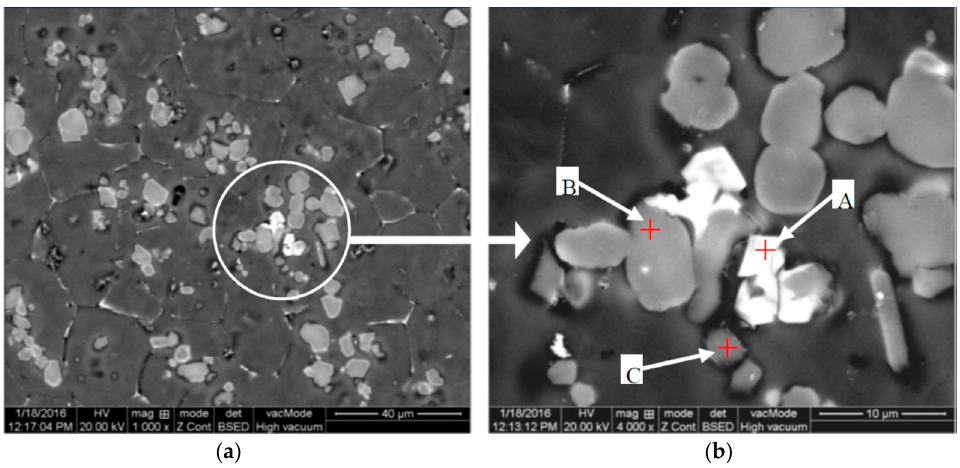
Figure 2. Microstructures of Al-5Ti-0.62C-0.2Ce master alloy: ( a ) SEM image; ( b ) SEM image of titanium compounds at higher magnification.